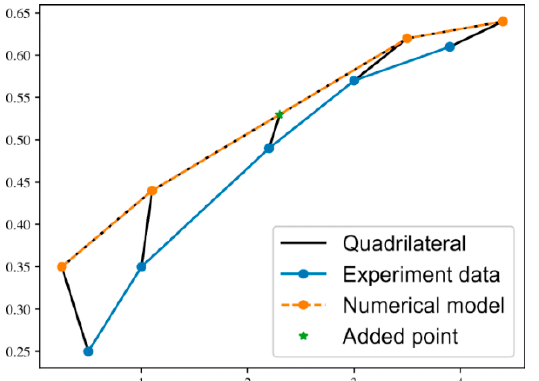
Figure 4. Example of the area calculation method [24]. It starts by ensuring both datasets are the same size, by adding points to the curve smaller in size (green added point). Connecting curve points in order forms quadrilaterals. The area of all quadrilaterals is calculated and summed